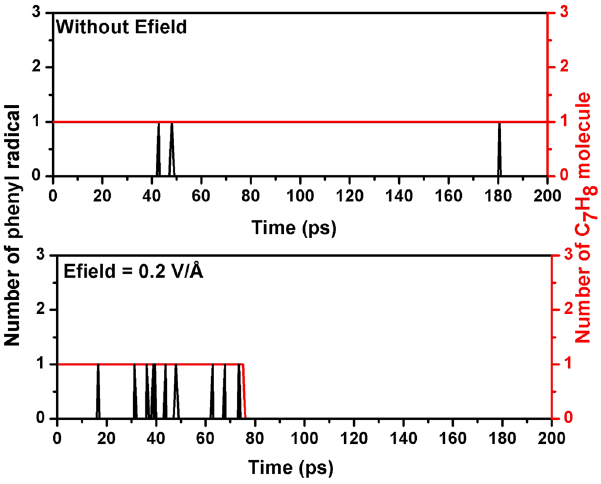
Figure 10. Production of phenyl radicals obtained during ReaxFF NVT-MD simulations with/without Efield = 0.2